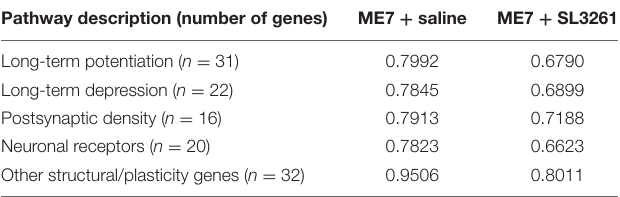
TABLE 2 | Functional gene group